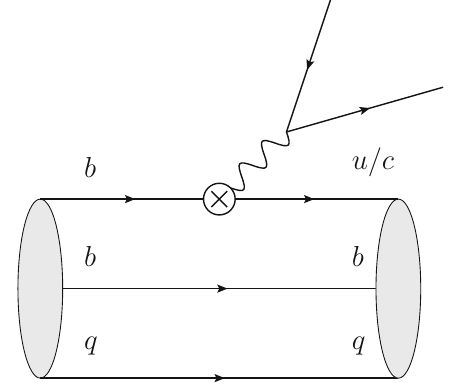
Fig. 3 The Feynman diagrams for the semileptonic decays of (cid:2) bb and (cid:5) bb Table 3 Similar to Table 2 but for the doubly bottom baryons Channel